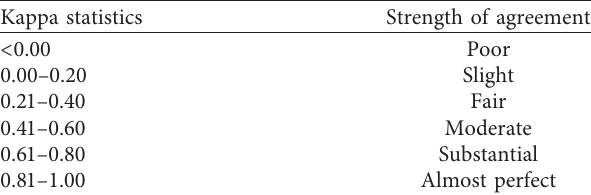
Table 3: Interpretation of kappa values by Landis and Koch scale.